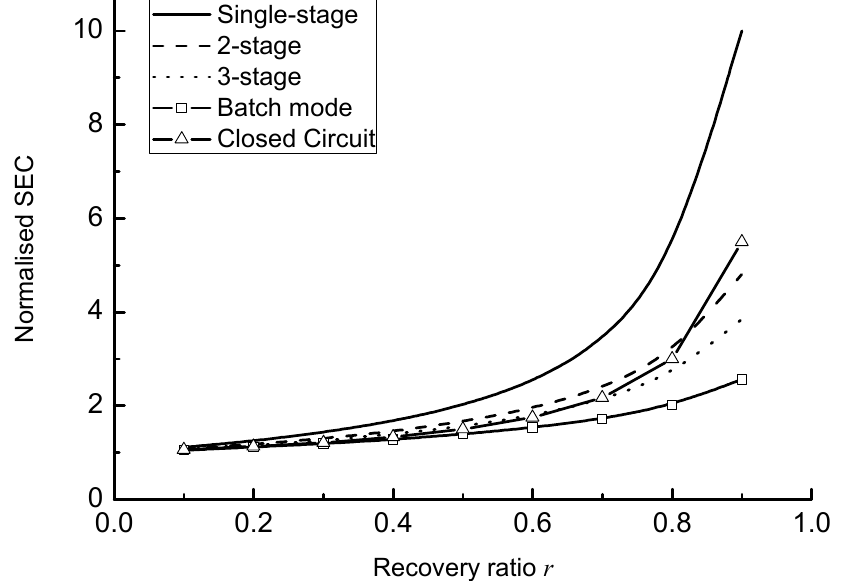
Figure 13. Theoretical limit of normalized SEC in batch-mode RO and multi-stage ROs with